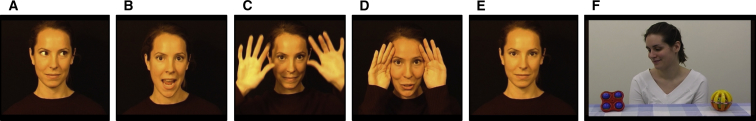
Selected Frames from the Stimuli(A–E) Illustrations of actor’s movements in eye movement (A), mouth movement (B), hand movement (C), peek-a-boo (coordinated movement of eyes, mouth, and hands) (D), and still face (E) in face-scanning task.(F) Head turn to an object in gaze-following task.